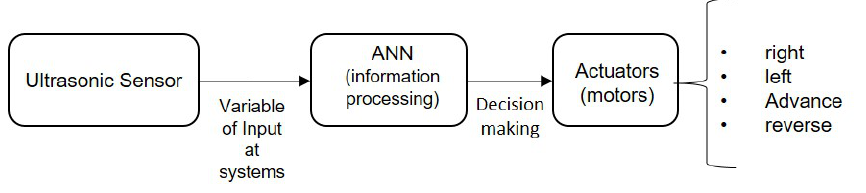
Figure 9. Block diagram of the system operation.